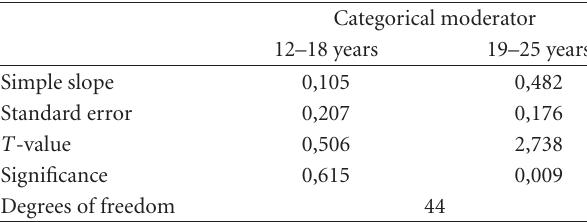
Table 6: Simple slope